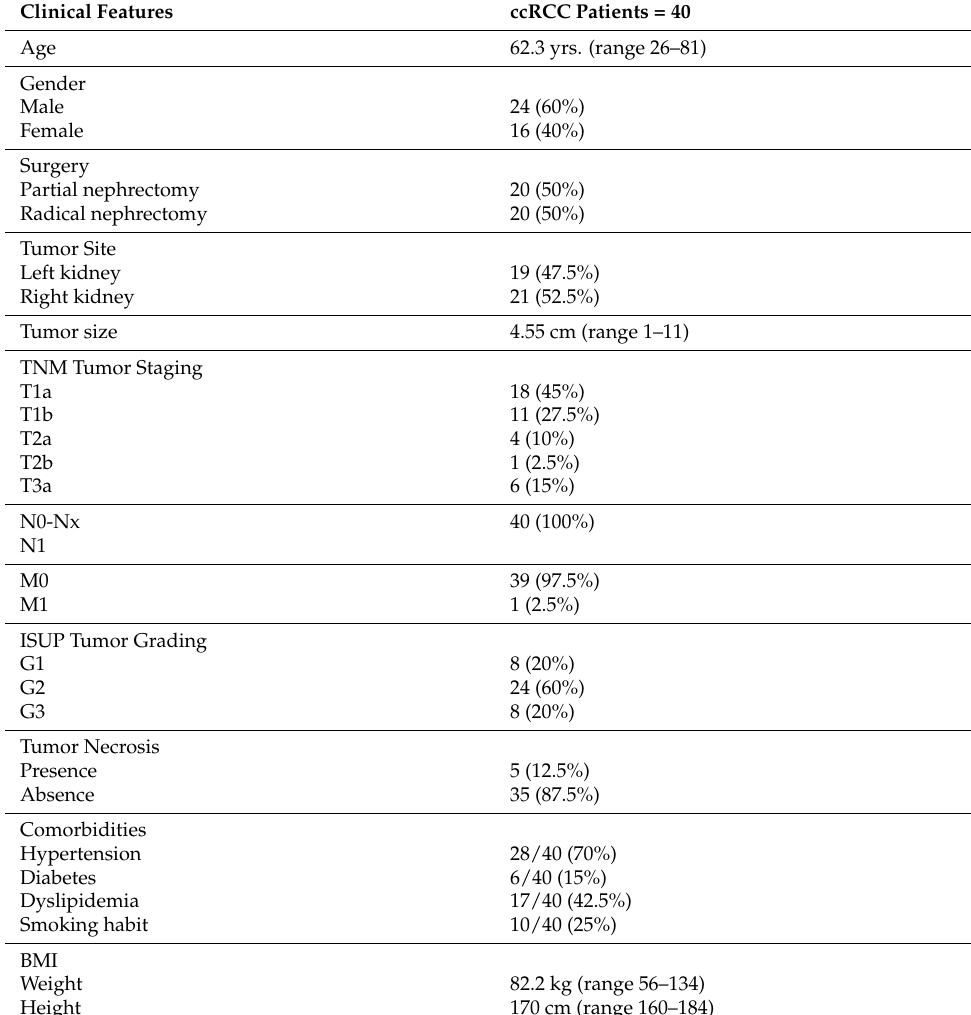
Table 1. Clinical-pathological characteristics. Clinical